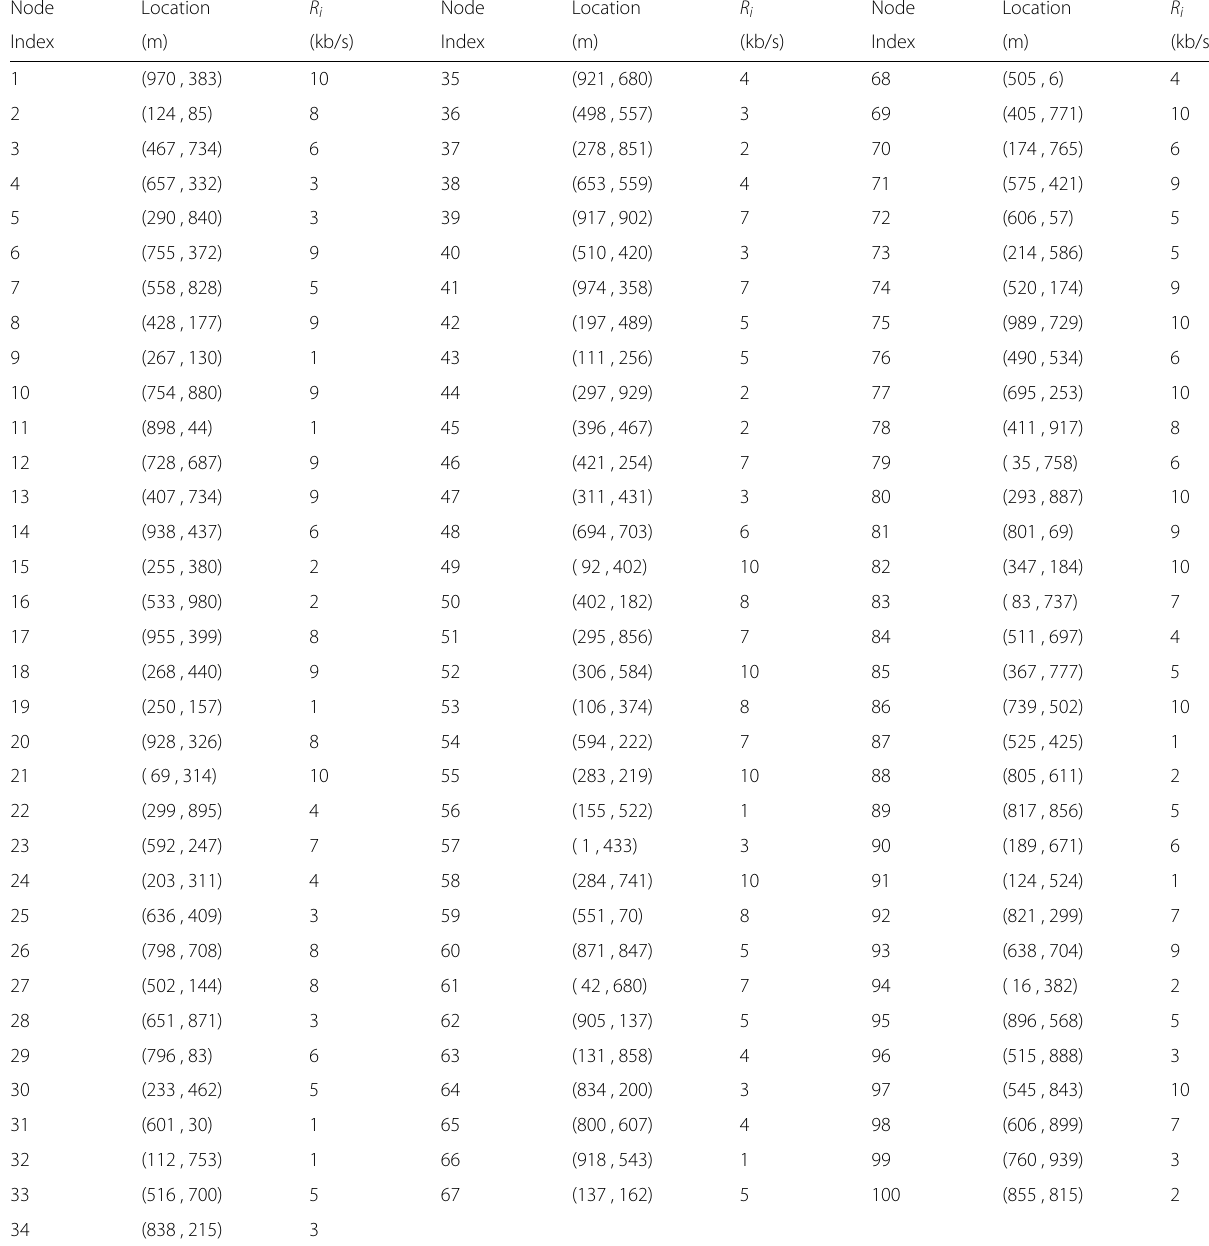
Table 5 Location and data rate for each node in a 100-node network